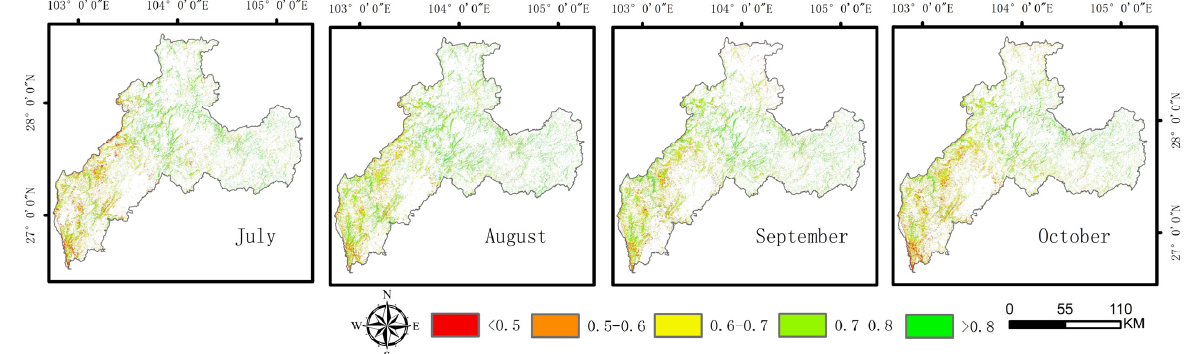
Figure 19. Classi fi cation of grassland growth from July to October 2021. Classify the NDVI values into 5 classes.